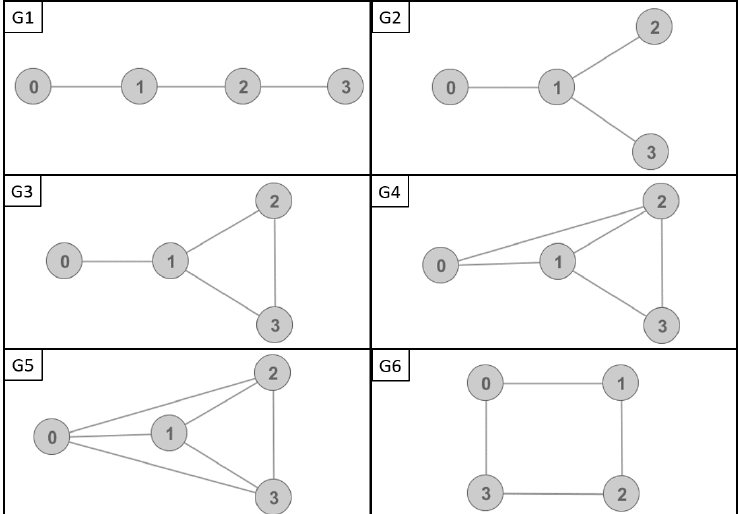
Figure 1. Six topologies of a 4-node network.